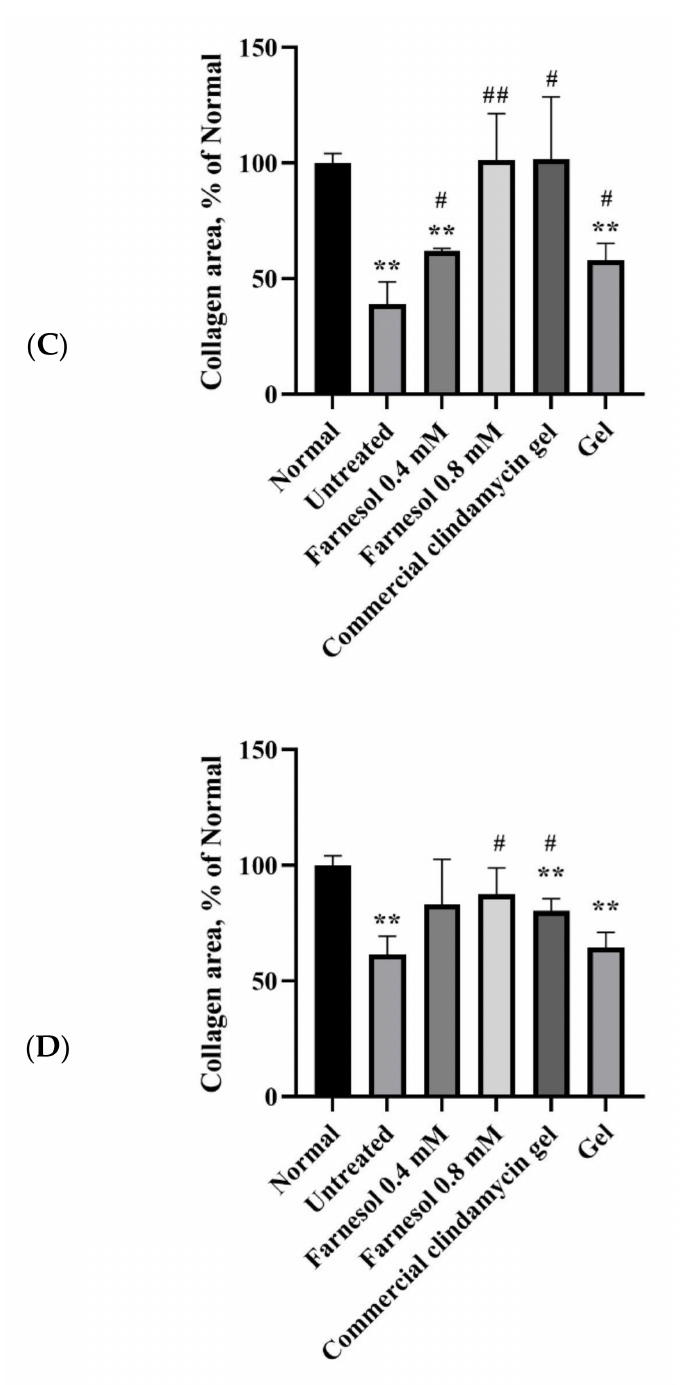
Figure 5. Masson’s trichrome staining of the dorsal skin of rats after two-time ( A ) and four-time ( B ) treatment with 0.4 mM farnesol, 0.8 mM farnesol, HPMC, and commercial clindamycin gels. Semiquantitative assessment of collagen from blue color stains in Masson’s trichrome images for ( C ) two-time and ( D ) four-time treatment groups ( n = 3). ** p < 0.01 (compared with the normal group); # p < 0.05 (compared with the untreated group), ## p <